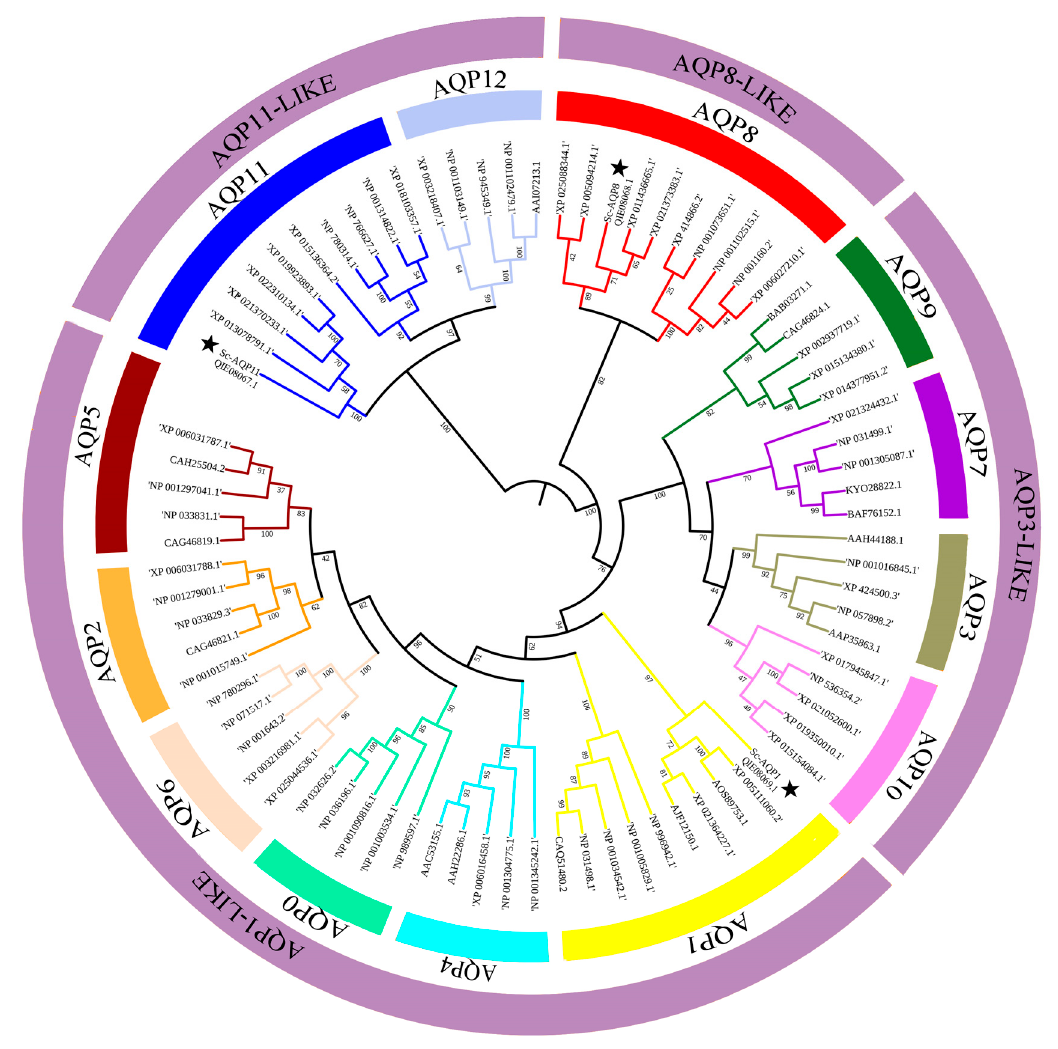
Figure 4. Phylogenetic analysis of three Sc- AQPs ( Sc -AQP1, Sc -AQP8, and Sc -AQP11) with AQP family members of other species. The phylogeny tree was built by using amino acid sequences of 80 available AQPs. The AQP genes of S. constricta are labeled with star. The sequences are described by the GenBank accession number, and the detailed information of these sequences are included in Supplementary Table S1.